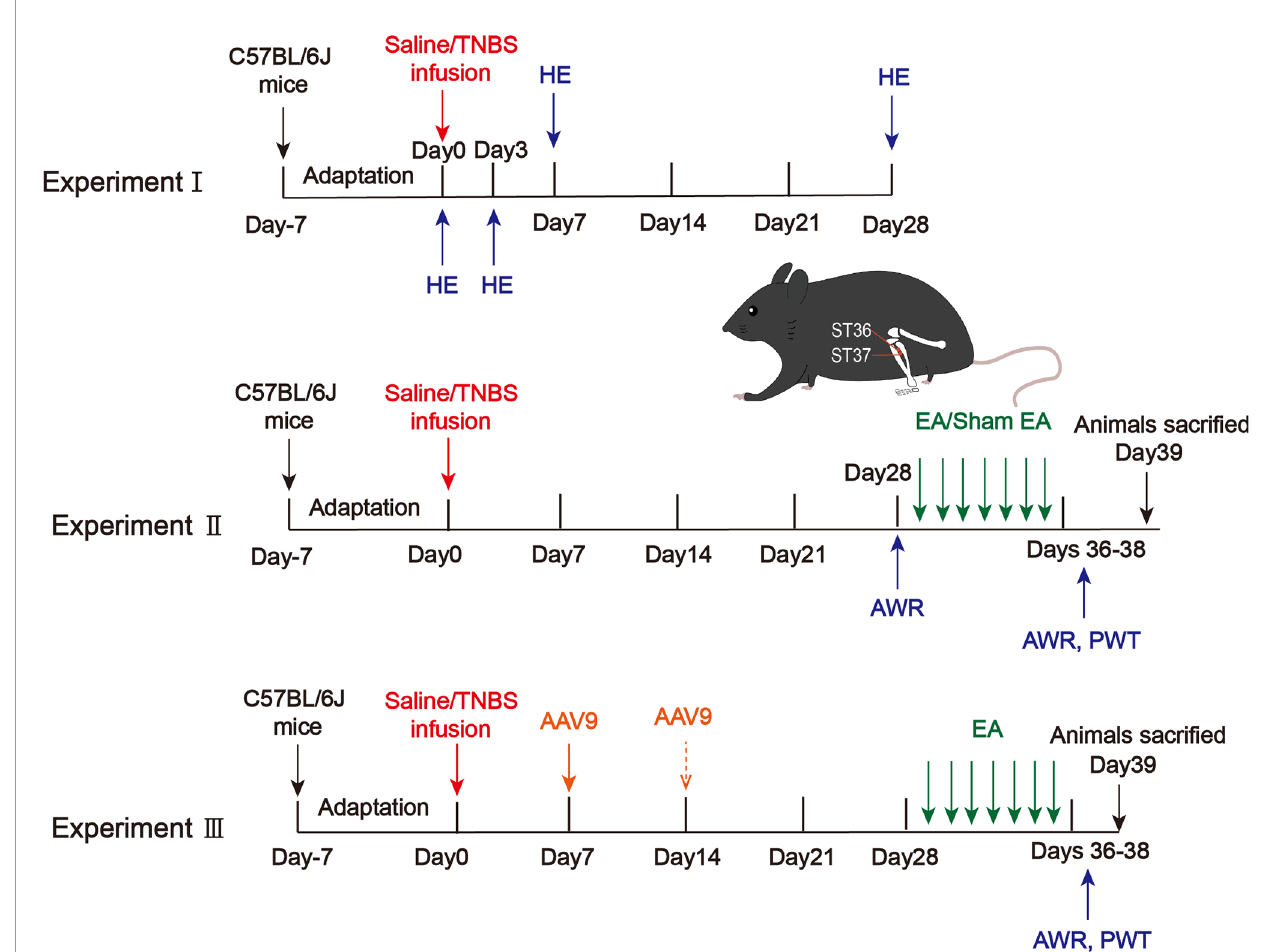
FIGURE 1 | Protocols for electroacupuncture manipulation of the PI-IBS model mice. TNBS, 2,4,6-trinitrobenzene sulfonic acid; HE, hematoxylin and eosin of colonic tissues; AWR, abdominal withdrawal re fl ex; EA, electroacupuncture; Sham EA, sham electroacupuncture; ST36, acupoint Zusanli; ST37, acupoint Shangjuxu; PWT, paw withdrawal